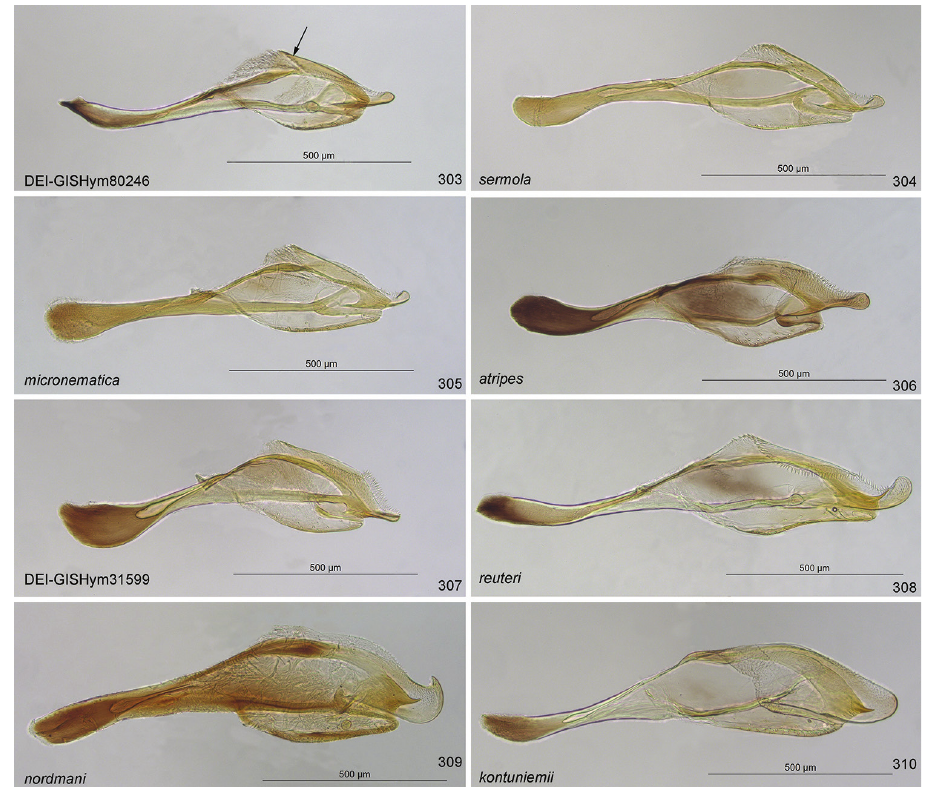
Figures 303–310. Penis valves of Pristiphora micronematica group. 303 DEI-GISHym80246 (arrow indicates a loose membranous region of pseudoceps) 304 sermola DEI-GISHym31580 305 micronemat- ica DEI-GISHym31592 306 atripes DEI-GISHym80249 307 DEI-GISHym31599 308 reuteri DEI- GISHym80250 309 nordmani paratype (DEI-GISHym31677) 310 kontuniemii DEI-GISHym31720, reared ex ovo from Salix daphnoides